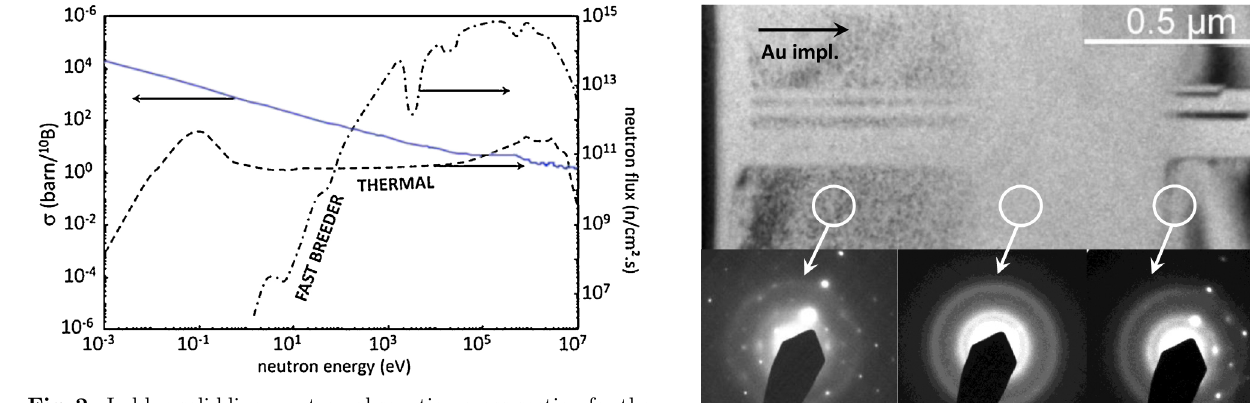
Fig. 2. In blue solid line: neutron absorption cross-section for the 10 B isotope (from Ref. [5]), superimposed to the neutron energy distribution (in black) in a pressurised water (- - thermal) and a fast neutron (- · - fast breeder) reactor (from Ref. [6]).